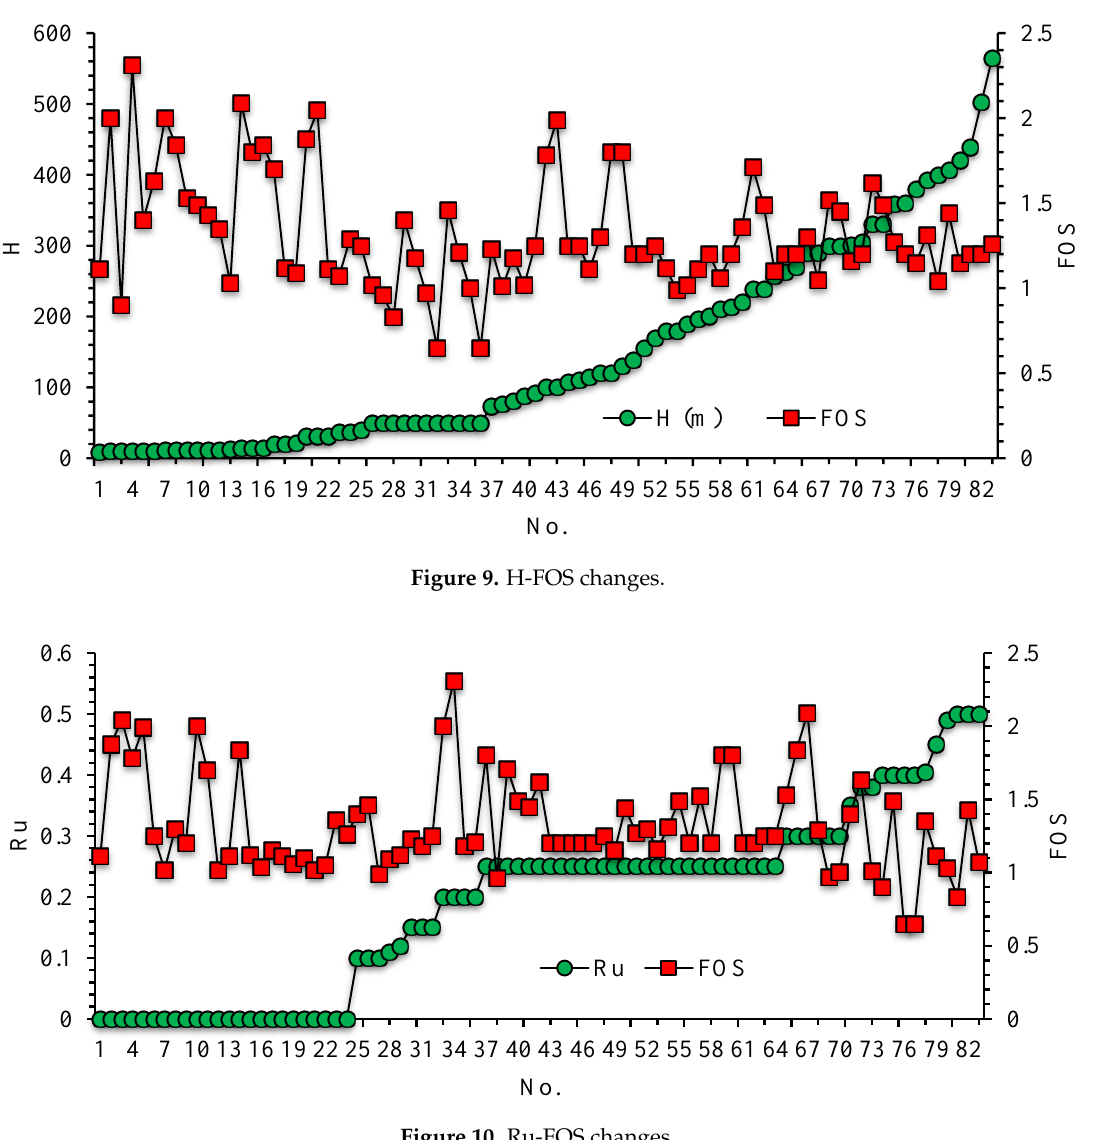
Figure 8. β -FOS changes.